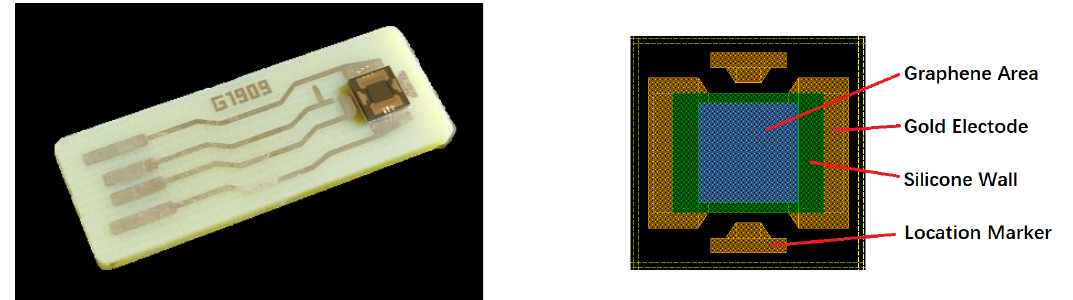
Figure 2. The photo of the GBC-100 graphene-based biosensor.